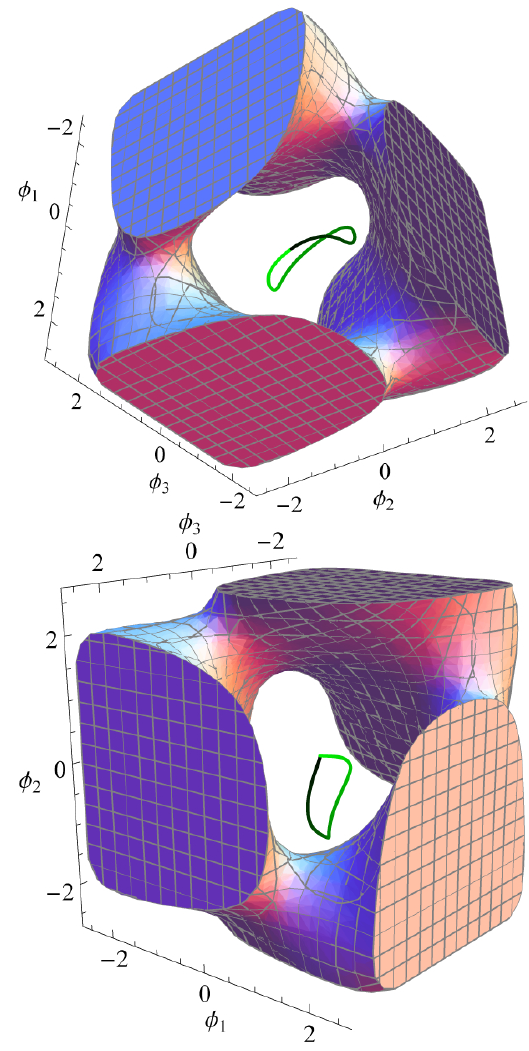
Figure 10. Motion in joint space φ : egalitarian solution (top) and prioritarian solution